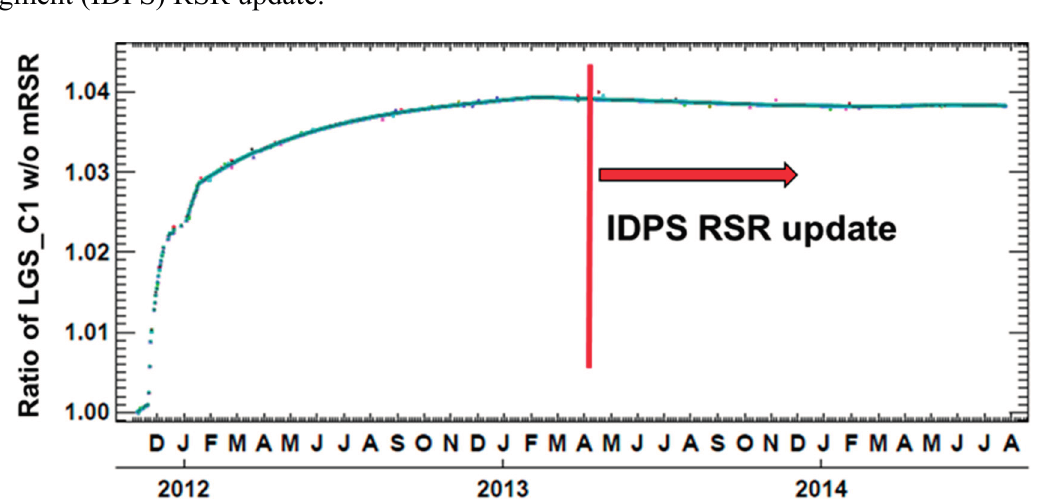
Figure 3. The ratios of LGS gains computed with and without using the time-dependent modulated RSRs. The vertical line indicates the timing of the Interface and Data Processing Segment (IDPS) RSR